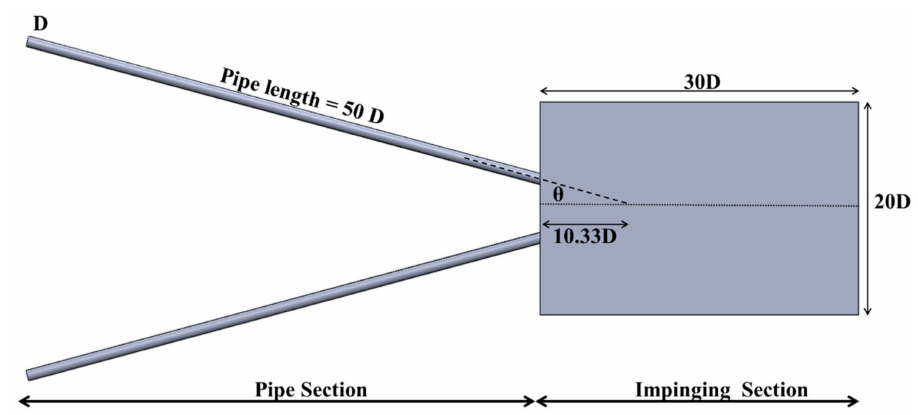
Figure 1. Schematic of full geometry showing pipe section and impinging jet